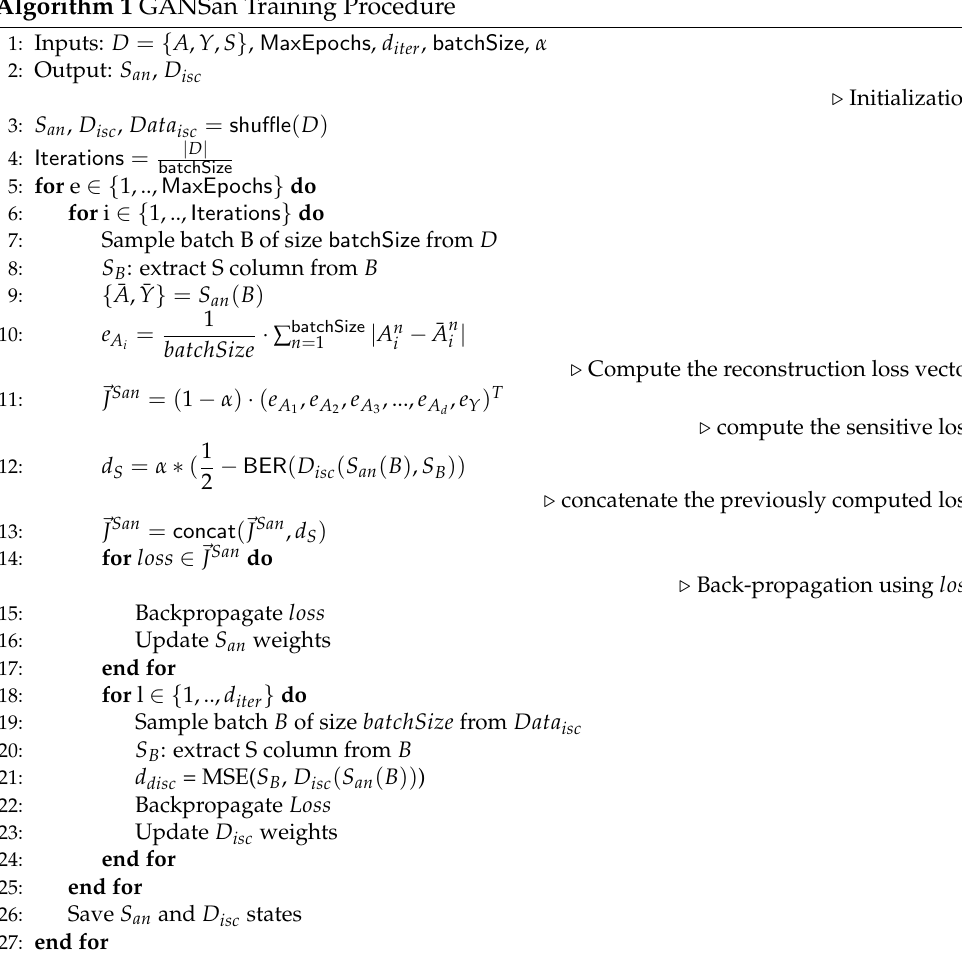
Algorithm 1 GANSan Training